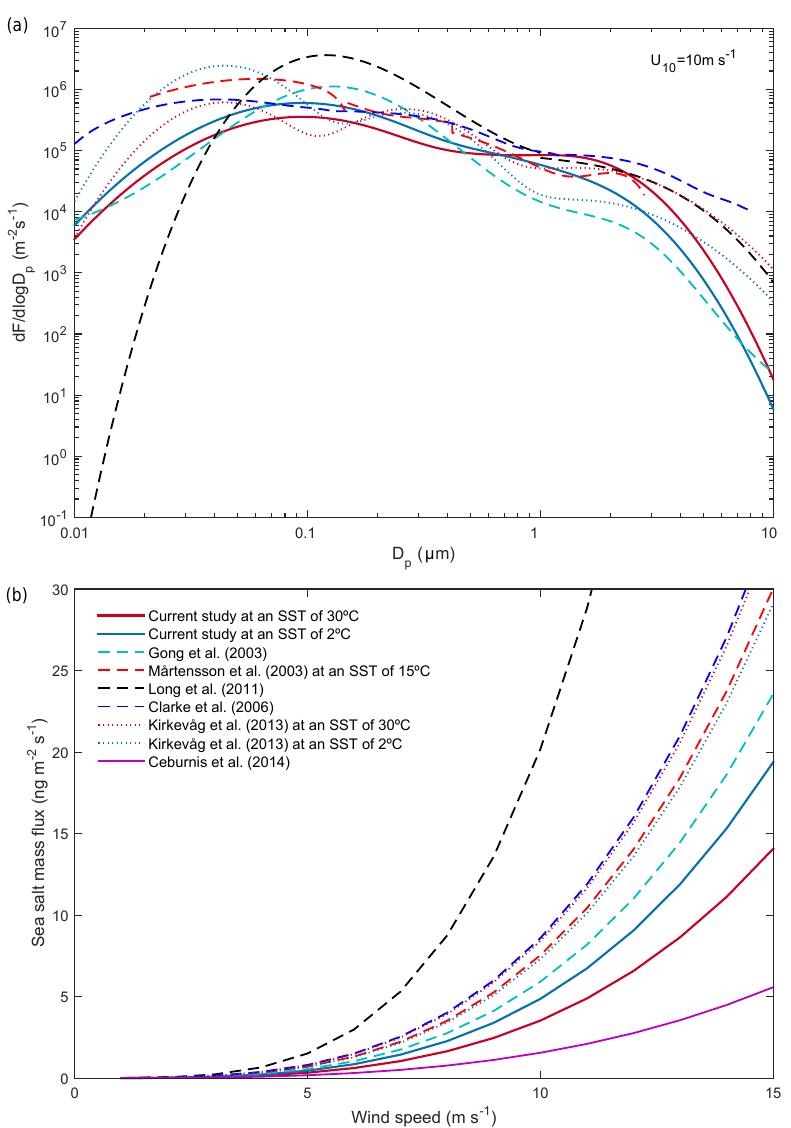
Figure 5. (a) The here derived sea spray source function (d F/ dlog D p ) for three different sea surface temperatures compared to the param- eterisations of Mårtensson et al. (2003), Gong (2003), Long et al. (2011), and Clarke et al. (2006), as well as the source function previously implemented in NorESM described by Kirkevåg et al. (2013) (see legend in b ). Panel (b) plots integrated (0 . 029µm < D p < 0 . 580µm) sea salt mass fluxes as a function of wind speed measured at 10m height for the same parameterisations shown in panel (a) as well as the fit to measured data reported by Ceburnis et al.